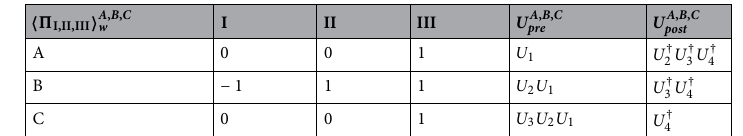
A , B , C (cid:31) I,II,III Table 1. Weak traces w Eq. (3) of a particle in a noise-less Vaidman interferometer at different (cid:31) (cid:30) instants A , B , C indicated in Fig. 1 and corresponding pre-and postselections given by A , B , C III ψ A , B , C and post � = U post | | �